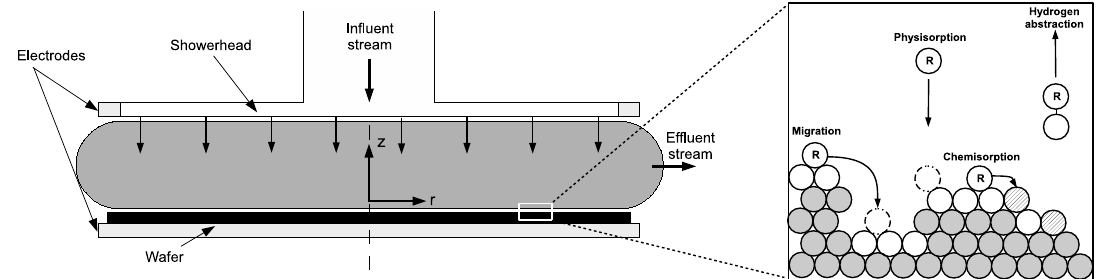
Figure 1. Macroscopic ( left ) and microscopic ( right ) PECVD simulation regimes.